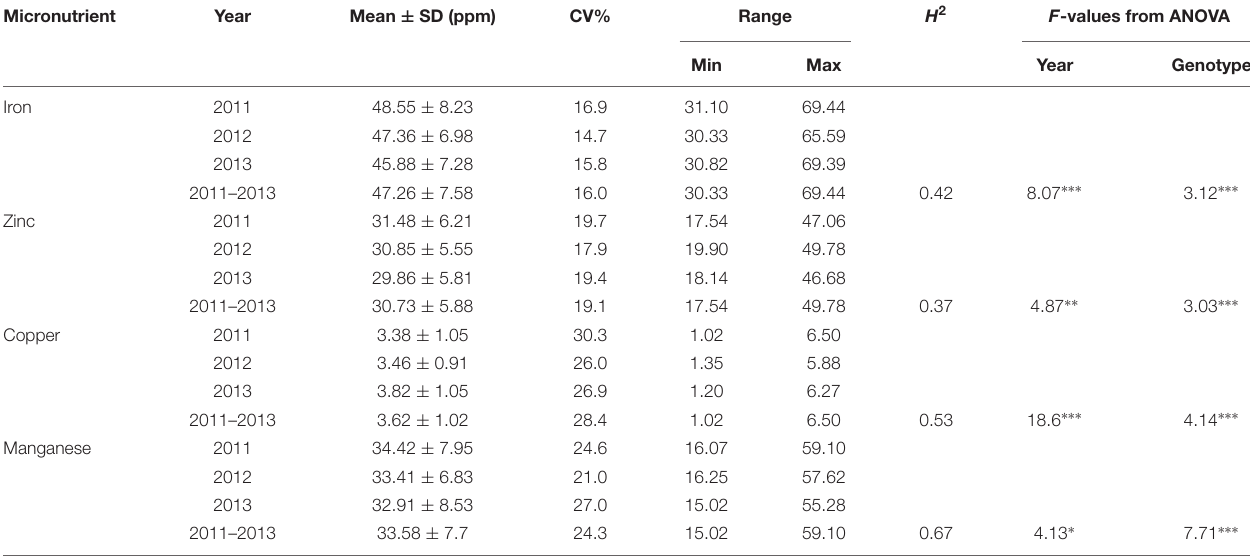
TABLE 1 | Descriptive statistics, broad sense heritability (H 2 ), and F -value from analysis of variance for the grain micronutrients concentration in year 2011, 2012, and 2013.